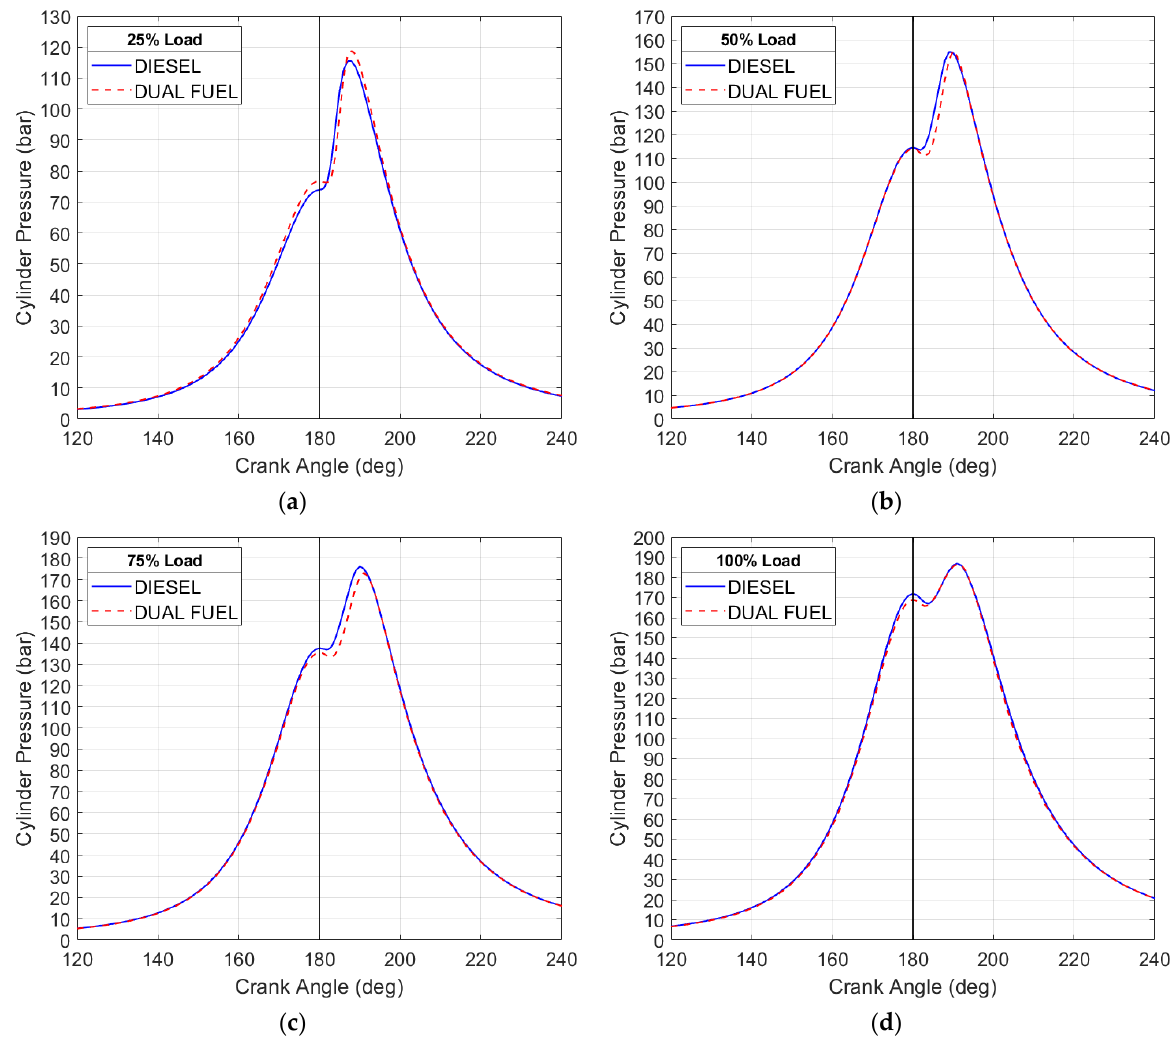
Figure 8. ( a ) Mean cylinder pressure traces at 25% load, diesel and DF modes; ( b ) Mean cylinder pressure traces at 50% load, diesel and DF modes; ( c ) Mean cylinder pressure traces at 75% load, diesel and DF modes; ( d ) Mean cylinder pressure traces at 100% load, diesel and DF modes.